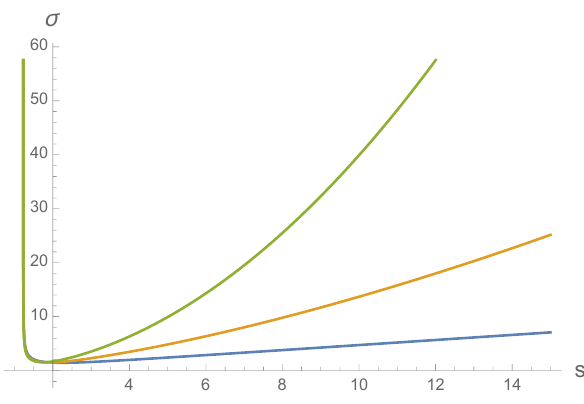
p Figure 6 . Plot of (cid:27) versus s for y = 3 = 2, for spacetime dimension d + 1 = 4 ; 5 ; 6 (blue, orange, and green lines, respectively). The results are qualitatively the same for every d